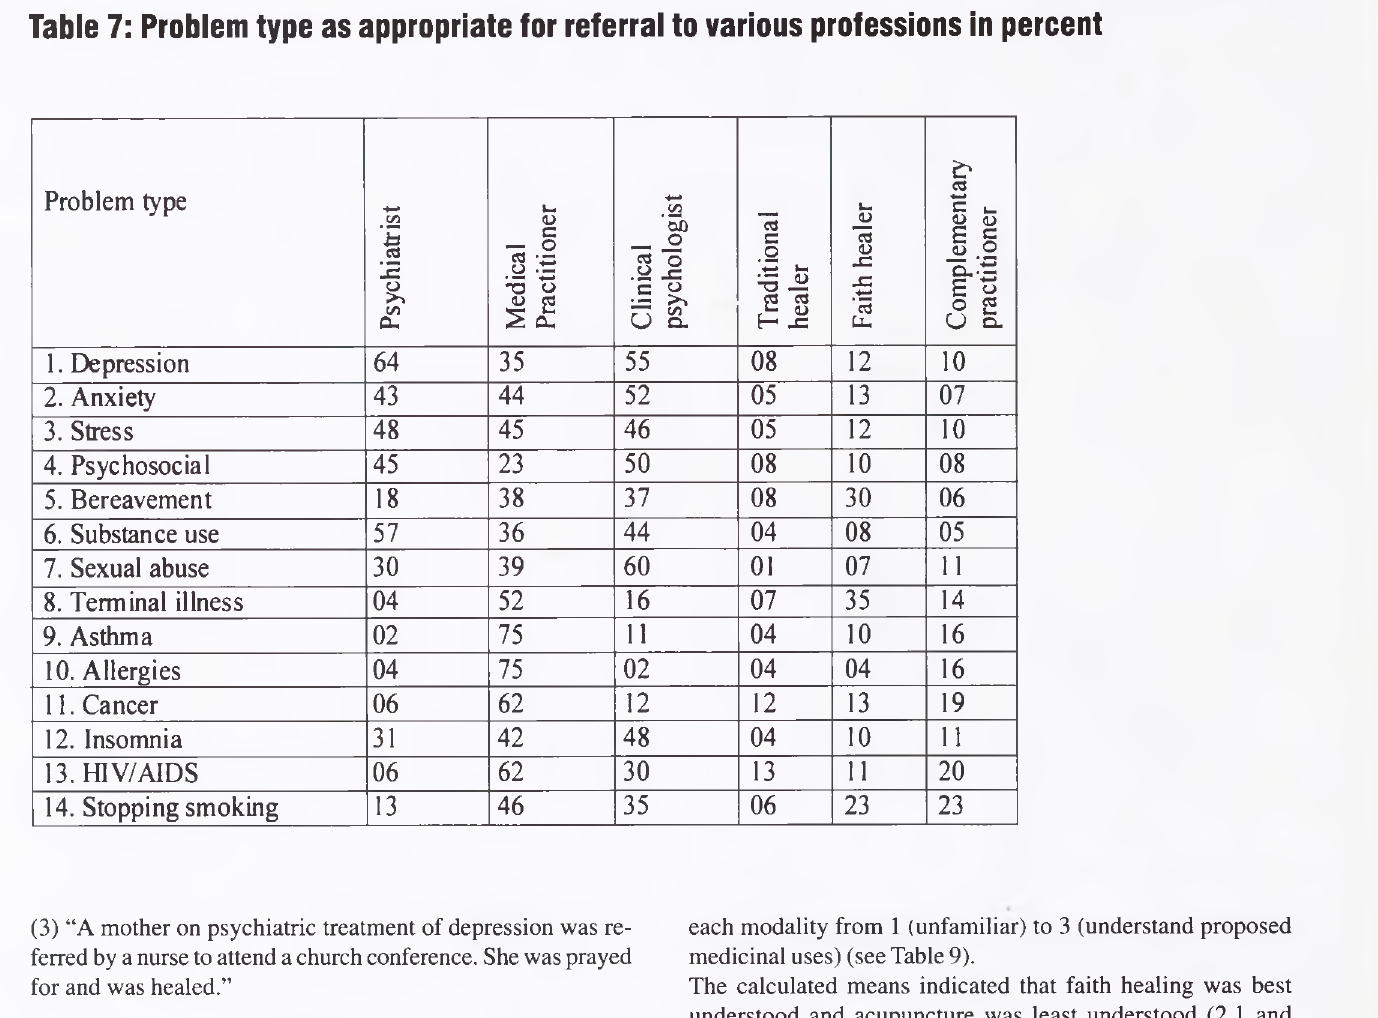
Table 7: Problem type as appropriate for referral to various professions in percent